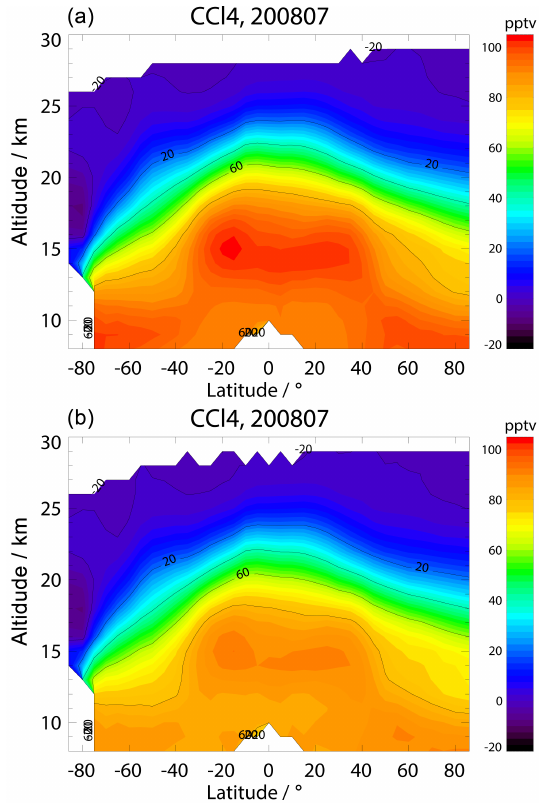
Figure 6. Altitude–latitude cross section of July 2008, using the spectroscopic data set by Nemtchinov and Varanasi (2003) (a) and using the new spectroscopic data by Harrison et al. (2017) (b) .